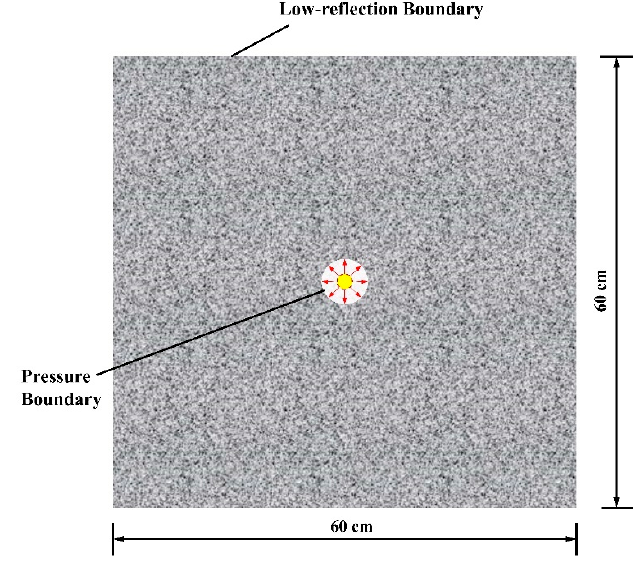
Figure 12. Mechanical equivalent model of electric pulse rock. Table 1. Parameters of electric pulse granite.